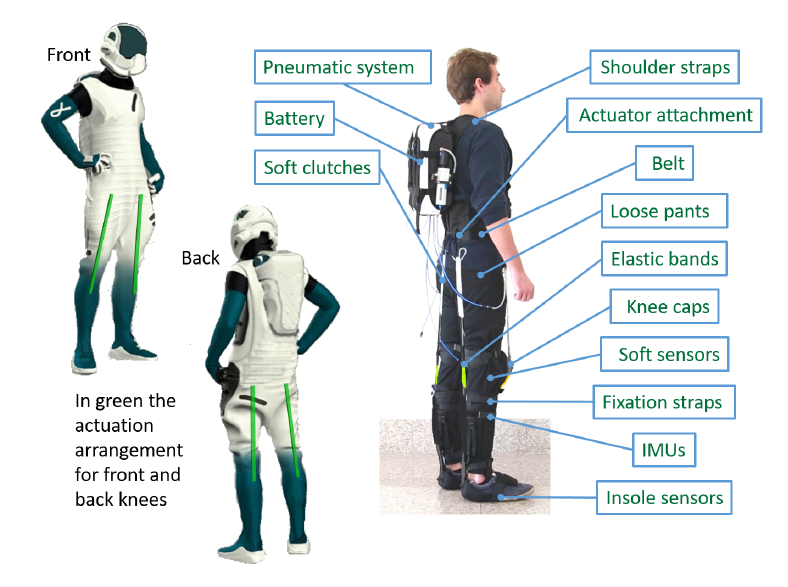
Figure 1. The system overview of the XoSoft Gamma exosuit used during the experimental evaluation. Written informed consent was obtained from the individual pictured in figure.